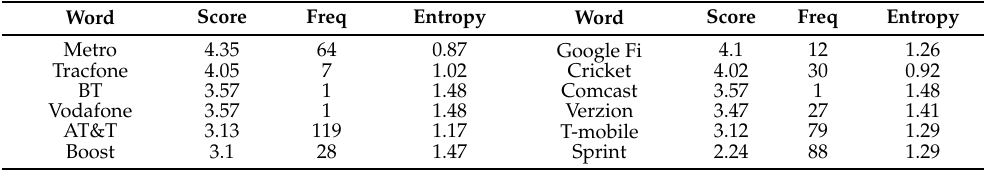
Table 16. Sentiment scores of carriers.